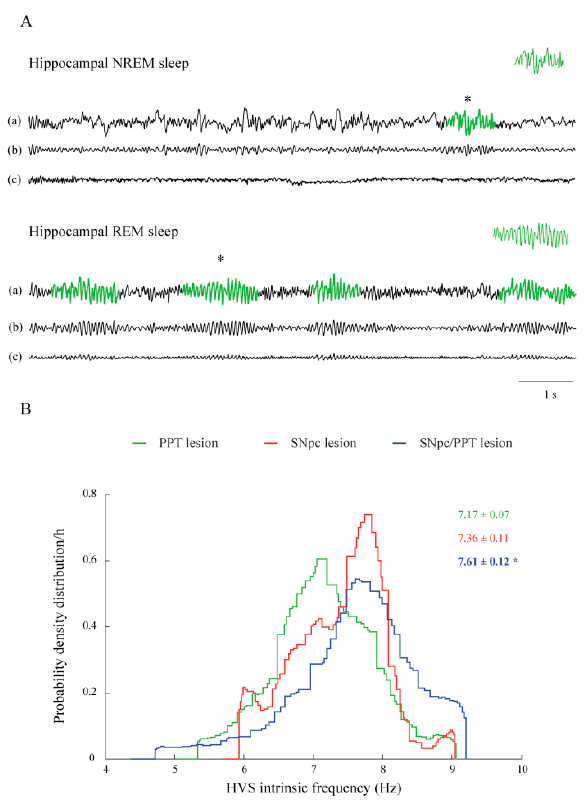
Figure 5. Hippocampal NREM/REM related HVS dynamic in the distinct rat models of PD neuropathology. ( A ) Individual examples of HVSs during hippocampal NREM and REM sleep in the rat with PD cholinopathy (PPT lesion): analog 20 s EEG signals of the hippocampal NREM and REM sleep with detected HVSs marked in green ( a ), corresponding band pass filter (4.1–10 Hz), used for the detection and extraction of the HVSs from the EEG signal ( b ), and corresponding EMG ( c ). The PD cholinopathy induced the prolongation and higher density of hippocampal HVSs during REM sleep. * marks the extracted examples of HVSs during hippocampal NREM and REM sleep (upper right inserts) in the rat model of PD cholinopathy. ( B ) The group probability density distributions of the hippocampal HVS intrinsic frequency during REM sleep in the distinct rat models of PD. The group distributions included an assembly of 104 HVSs from eight rats with PD cholinopathy, 35 HVSs from five hemiparkinsonian rats, and 56 HVSs from eight hemiparkinsonian rats with PD cholinopathy. Bold numbers with * indicate the statistically significant difference of the hippocampal mean HVS intrinsic frequency values during REM sleep at p ≤ 0.05 following Mann–Whitney U-test. The hemiparkinsonism with PD cholinopathy increased the hippocampal HVS intrinsic frequency during REM sleep (SNpc/PPT lesion, the right shifted distribution, blue line). Hemiparkinsonism induced the SSs occurrence during hippocampal NREM sleep (Table 1, SNpc lesion), but it induced the HVSs occurrence only during REM sleep within both the motor cortex and hippocampus (Table 2, SNpc lesion).